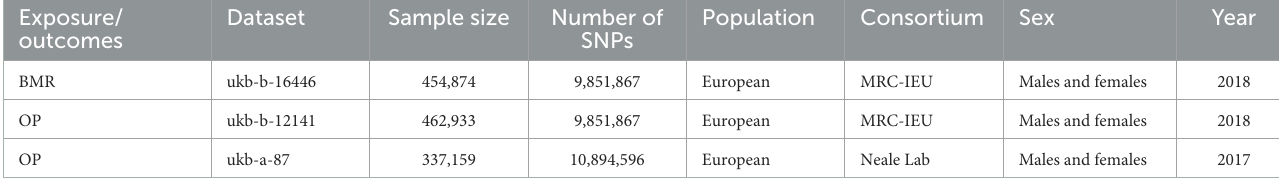
TABLE 1 Summary of the GWAS included in this two-sample MR